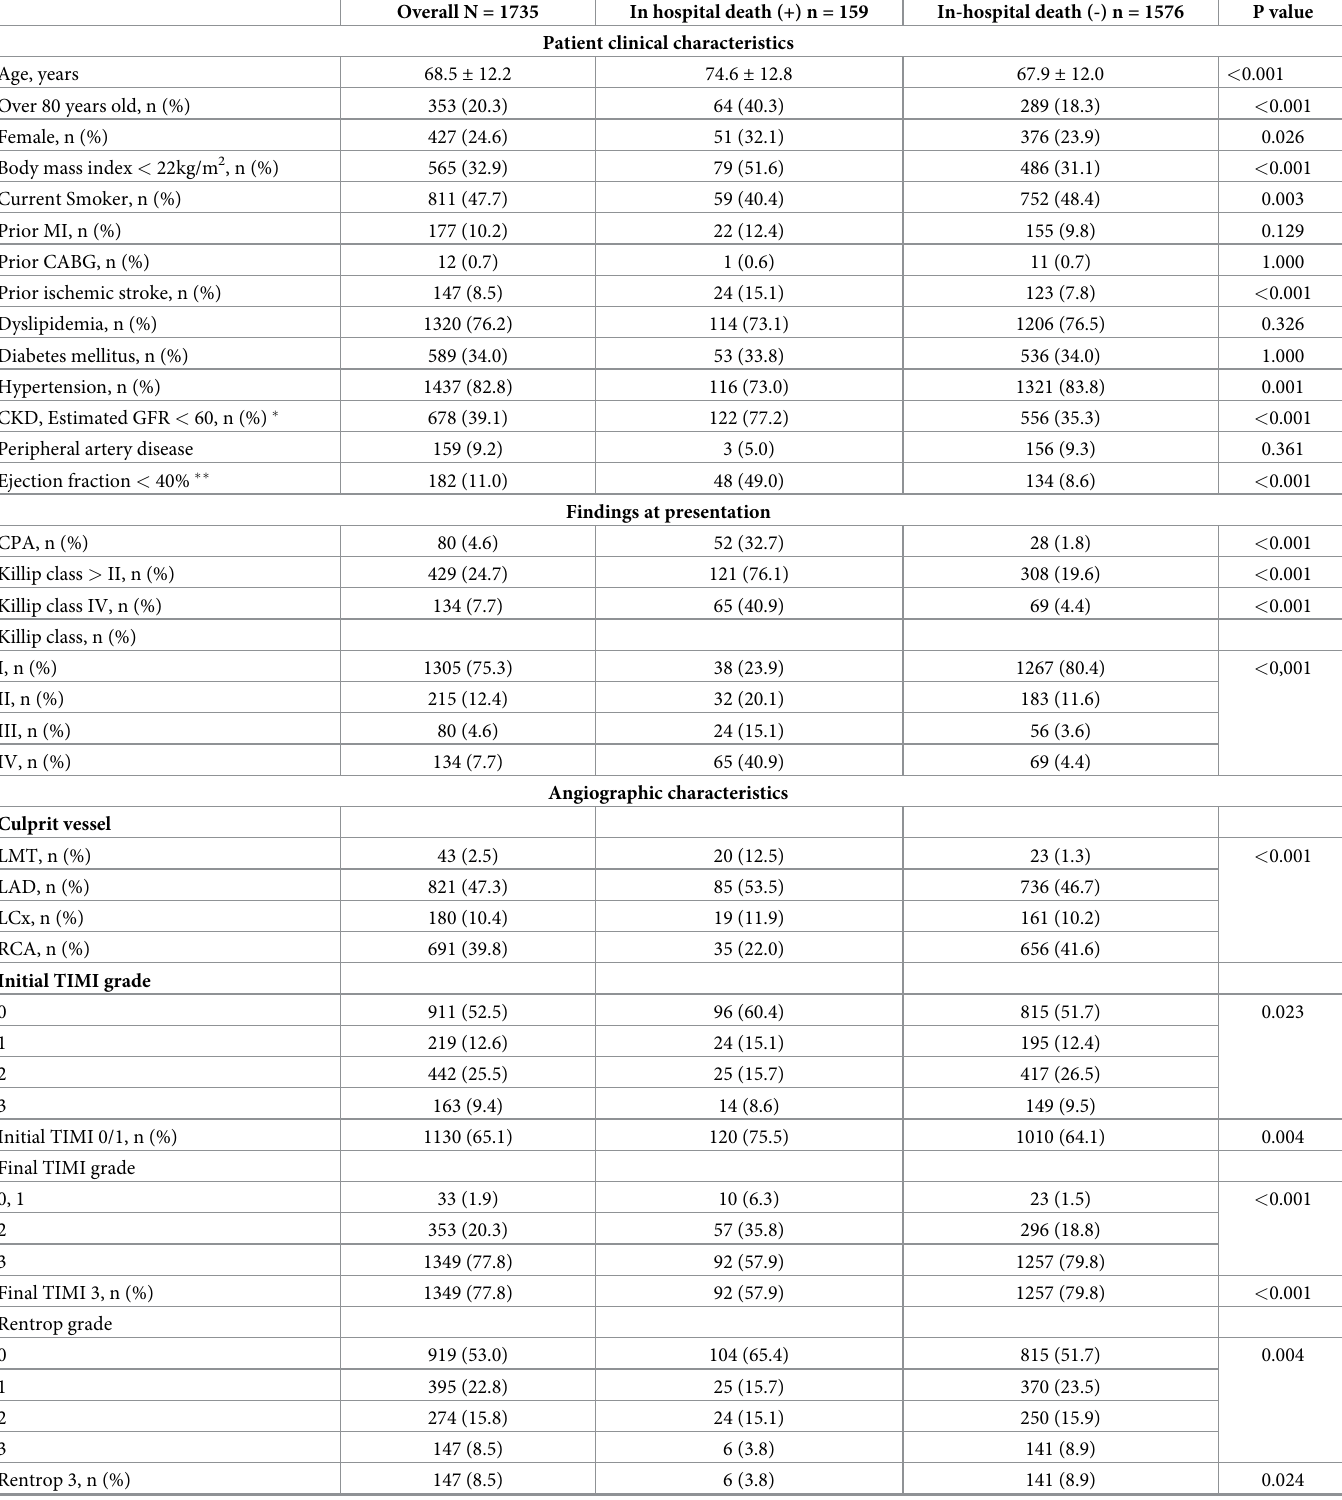
Table 1. Baseline patient, angiographic, and procedural characteristics (n =